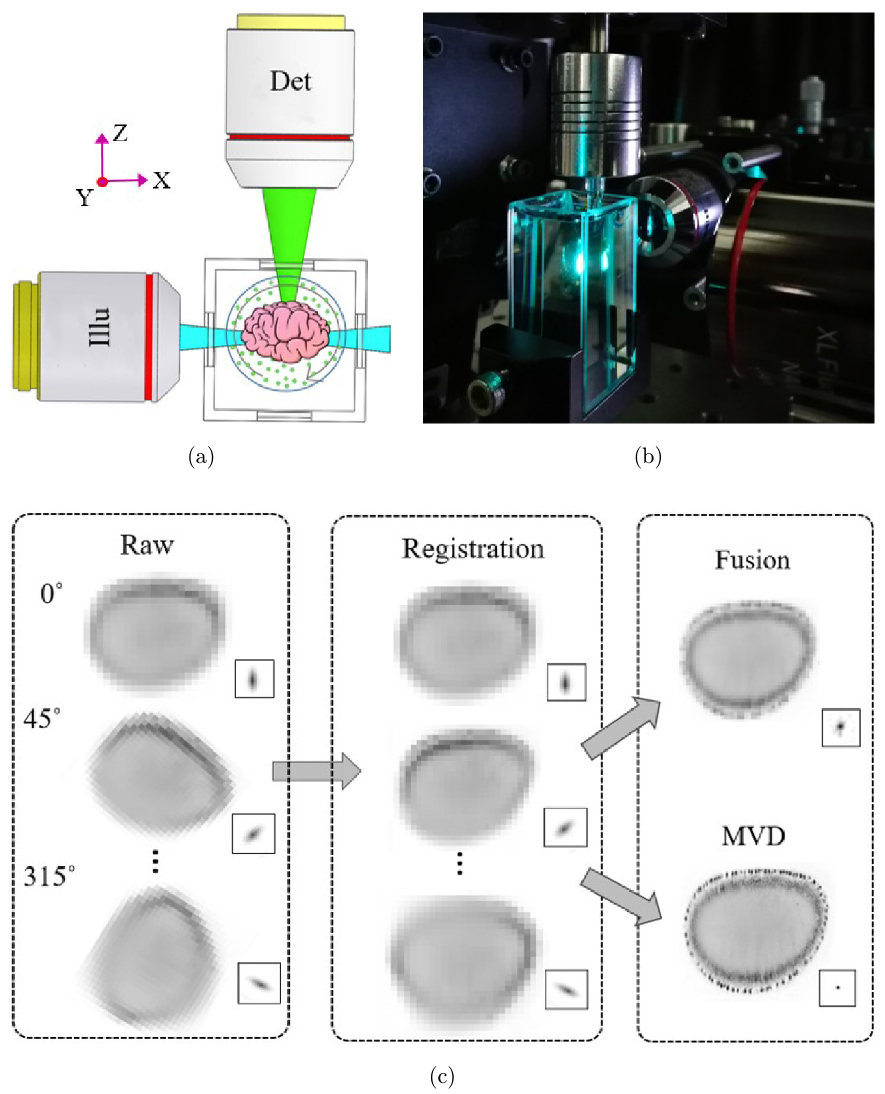
Fig. 1. Schematic of the multi-view LSFM imaging. (a) The illumination objective excites a thin plane of the brain sample using a line-focused laser-sheet. The orthogonal detection objective collects the °uorescence emission from the illuminated plane. 3D optical sectioning is accomplished by scanning the sample along z -axis. Through rotating the sample around y -axis, we then repeat the 3D imaging under multiple views. (b) Shows a photograph of real-world scene. (c) A brief °ow chart showing the essential procedures of multi-view data